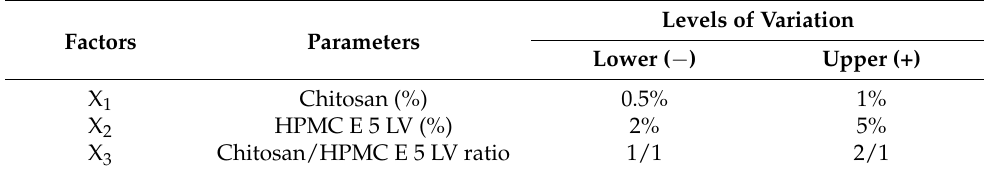
Table 2. Factorial plan for in situ gelling systems based on chitosan and HPMC E 5 LV with three factors and two levels of